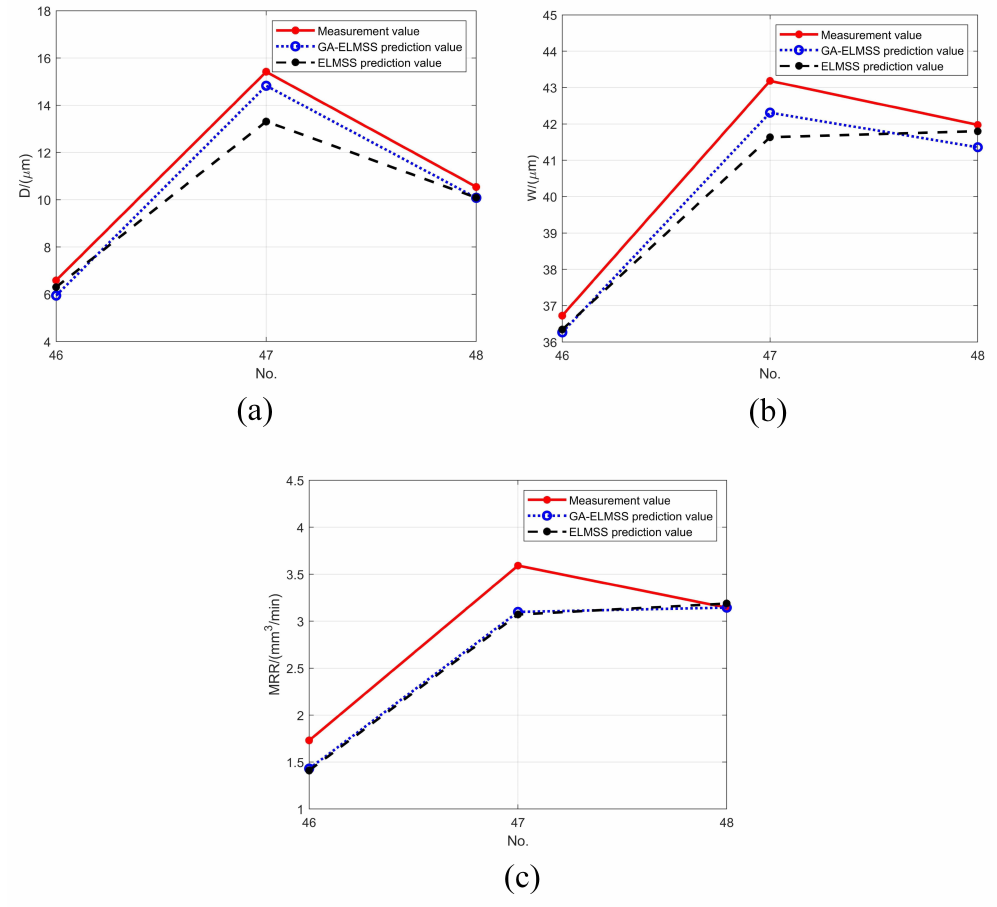
Figure 10. Comparison of the prediction results of the GA-ELMSS. ( a ) The prediction results of GA-ELMSS for D. ( b ) The prediction results of the GA-ELMSS for W. ( c ) The prediction results of GA-ELMSS for MRR.